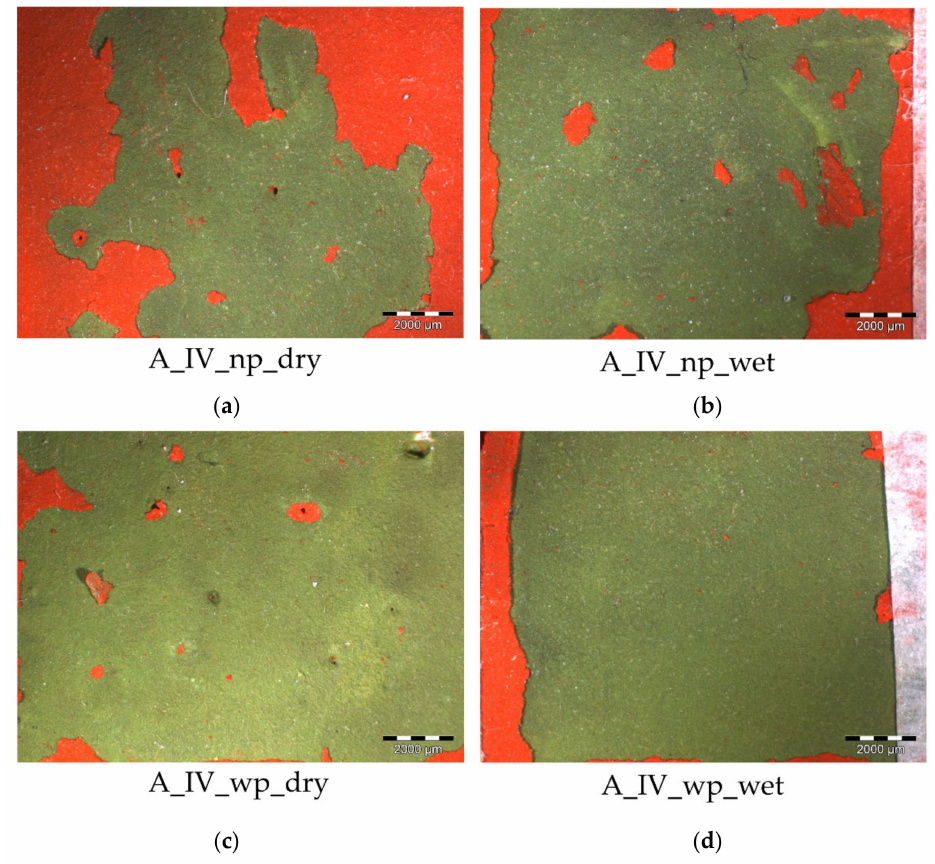
Figure 3. Optical images at 10 × of mock-up A treated with laser at 6 Hz frequency and fluence of approximately 1.35 J / cm 2 ( a , c ) and at 6 Hz frequency and fluence of approximately 2.60 J / cm 2 ( b , d ) both on unprotected (np) and protected (wp) area. ( a ) A_IV_np_dry; ( b ) A_IV_np_wet; ( c ) A_IV_wp_dry; ( d )